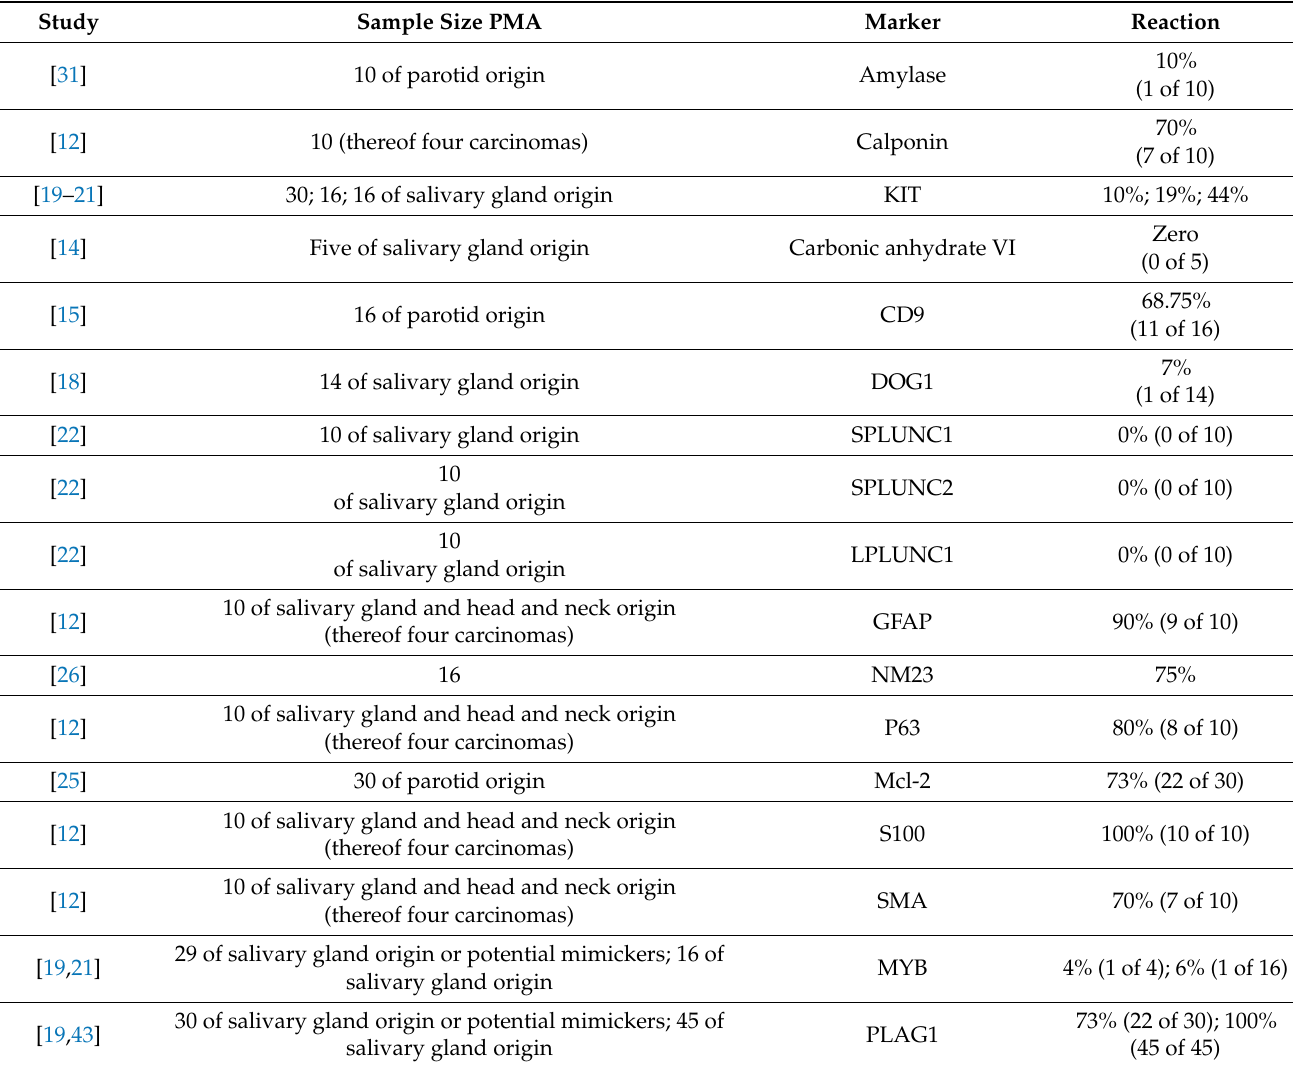
Table 5. Pleomorphic adenoma result